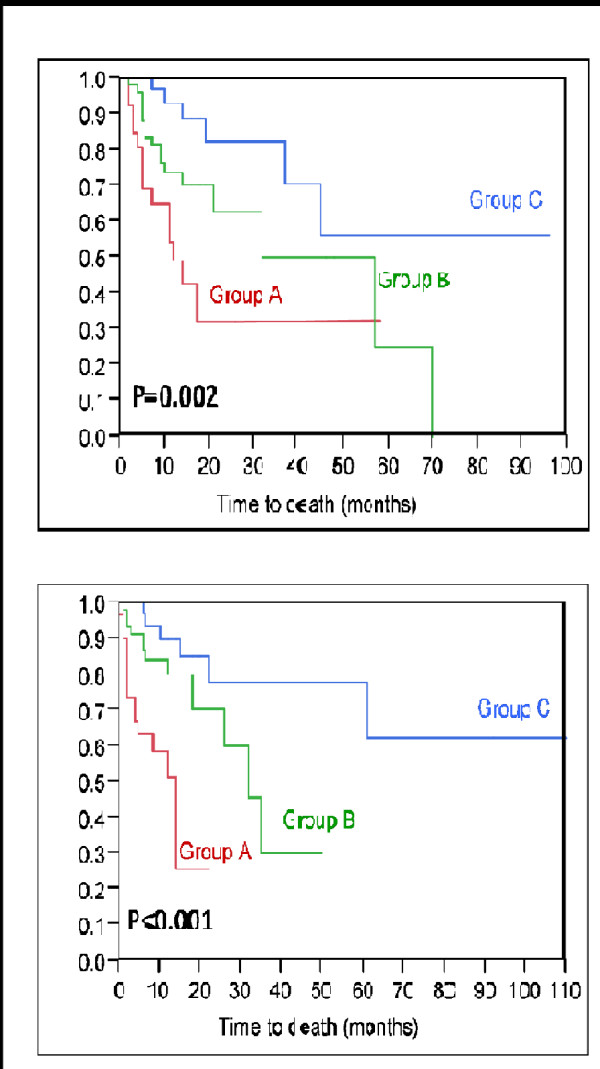
Kaplan-Meier curves for survival of the three score groups A (19–20 points), B (21–23 points), and C (24 points) from the test group (top) and from the validation group (bottom).